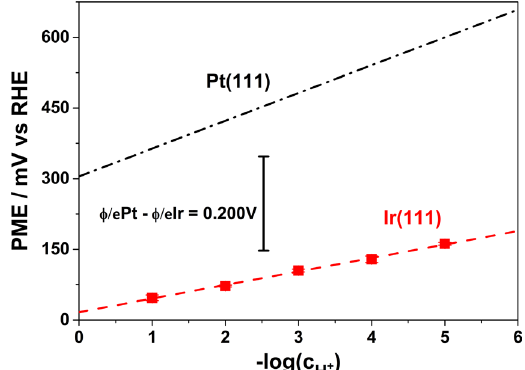
Figure 11. PME-trends as a function of pH elucidated in this work for Ir(111) and for Pt(111) as reported by Garcia-Araez et al . 41 . The difference in the work functions of Pt(111) and Ir(111) in vacuum is also shown for the sake of